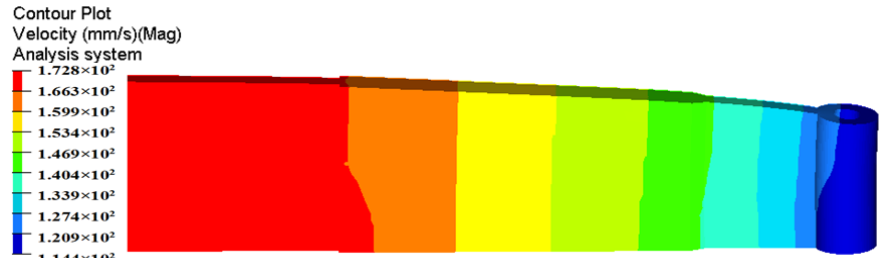
Figure 10. Velocity distribution in the extruded profile for the first modification scheme.